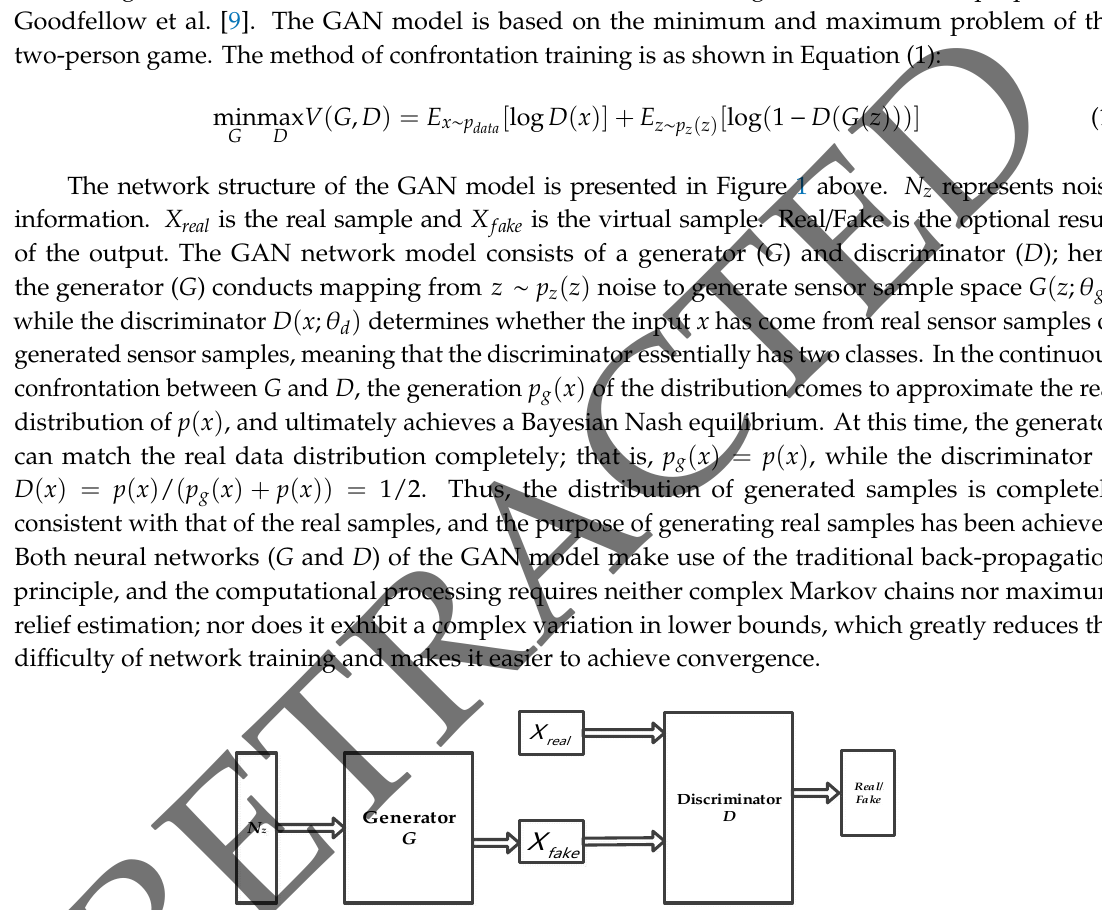
Figure 1. The original GAN network structure [9].